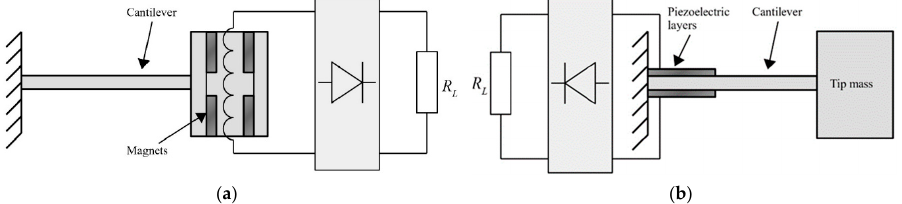
Figure 12. Model of electromagnetic ( a ) and piezoelectric ( b ) vibration EH systems for output power analysis [58].